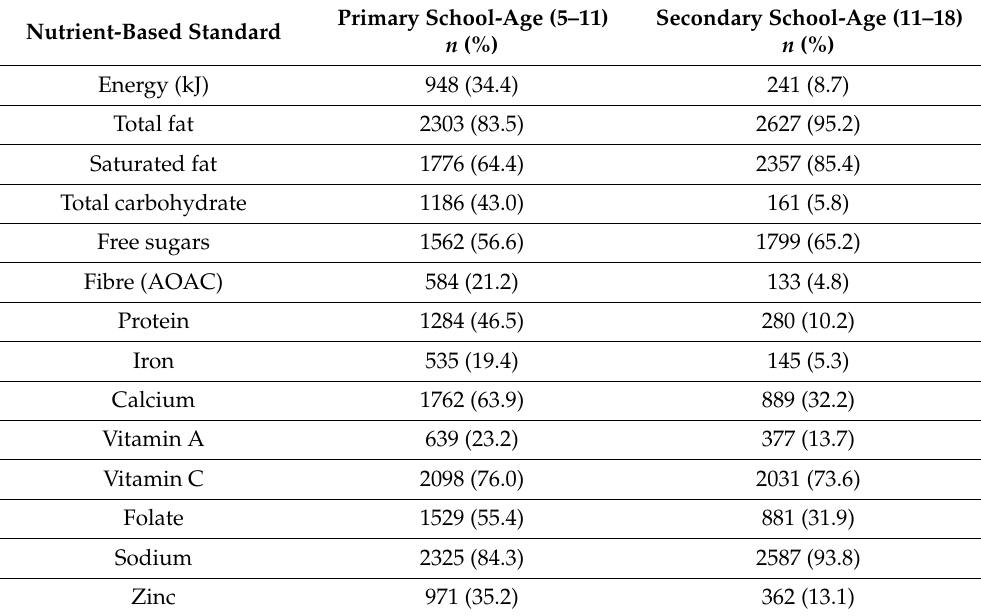
Table 3. Number and percentage of HAF menu variants ( n = 2759) meeting the nutrient-based standards for 5–11 years and 11–18 years